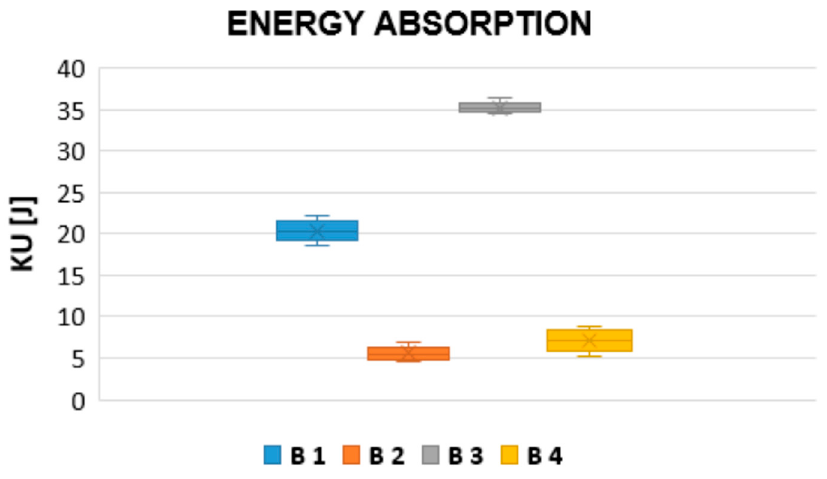
Figure 7. Measured values of energy absorption for individual clad layers.